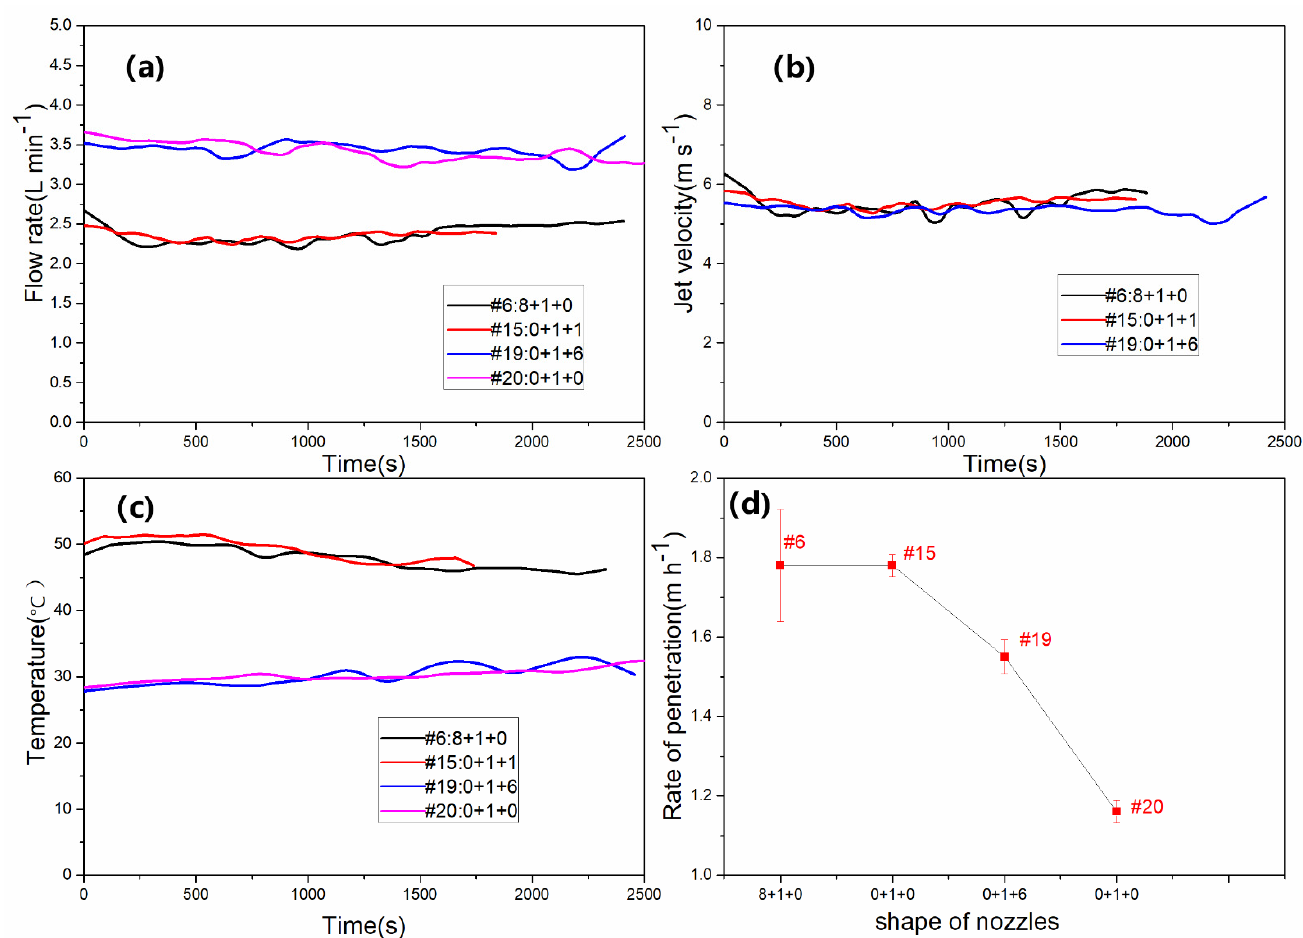
Figure 13. Drilling parameters comparison between nozzles of different types: ( a ) flow rate vs. time; ( b ) jet velocity vs. time; ( c ) temperature vs. time; ( d ) rate of penetration vs. time.